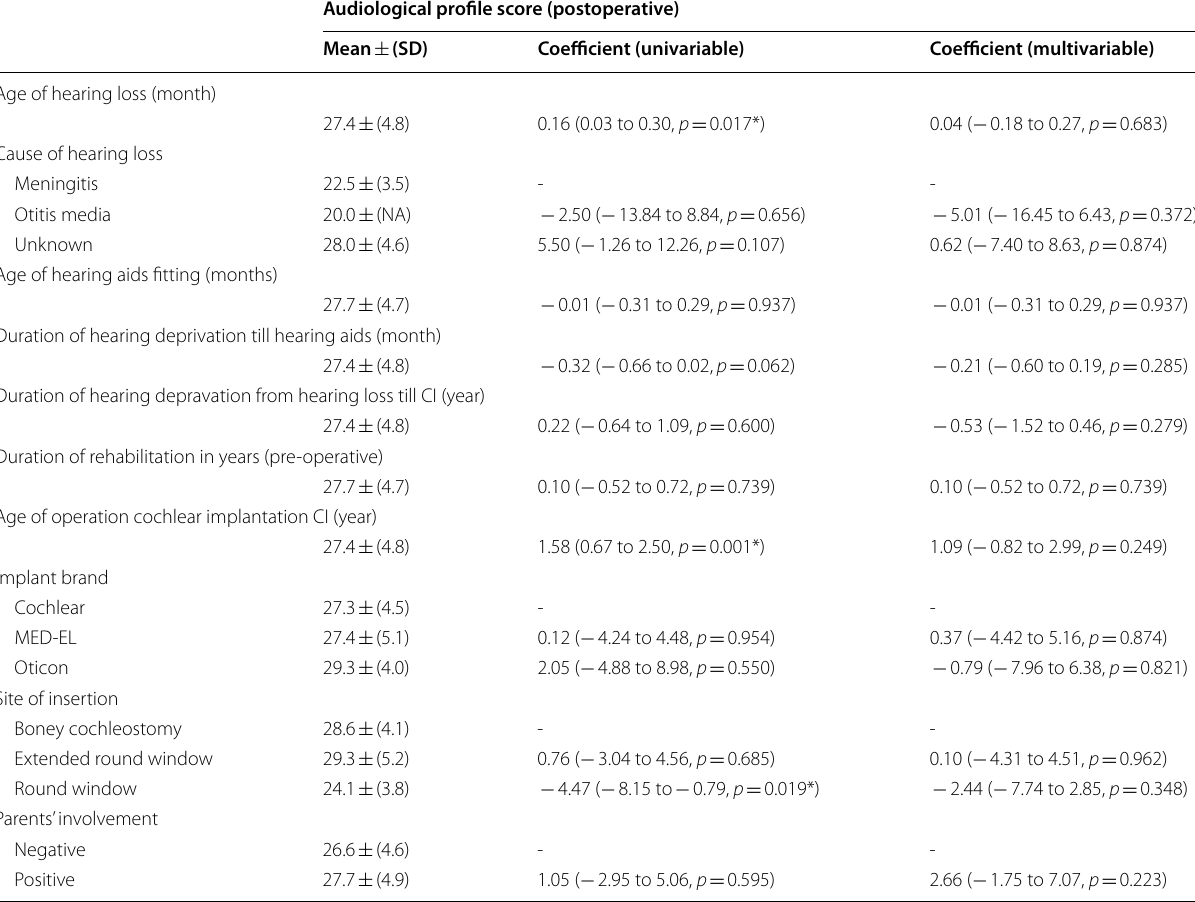
P value < 0.05, significant; P value < 0.01, highly